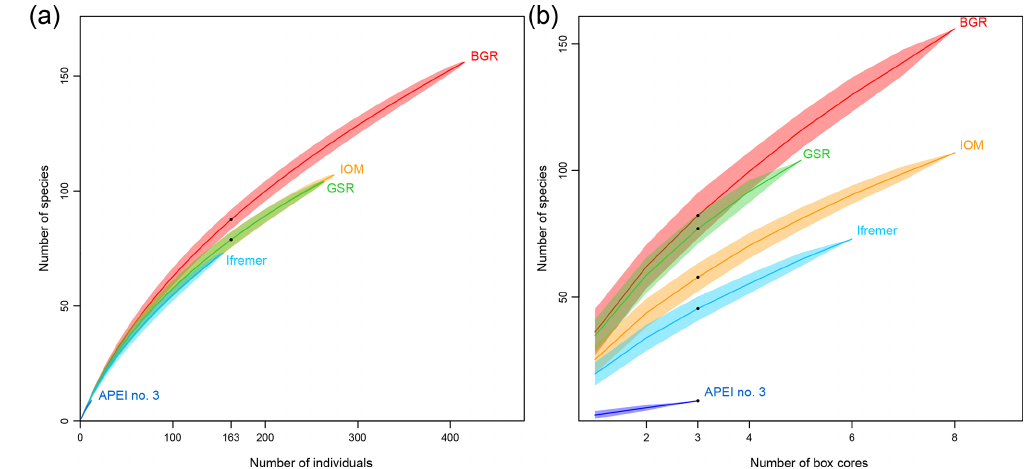
Figure 6. Rarefaction curves based on individuals (a) and samples (b) for each sampled area within the eastern